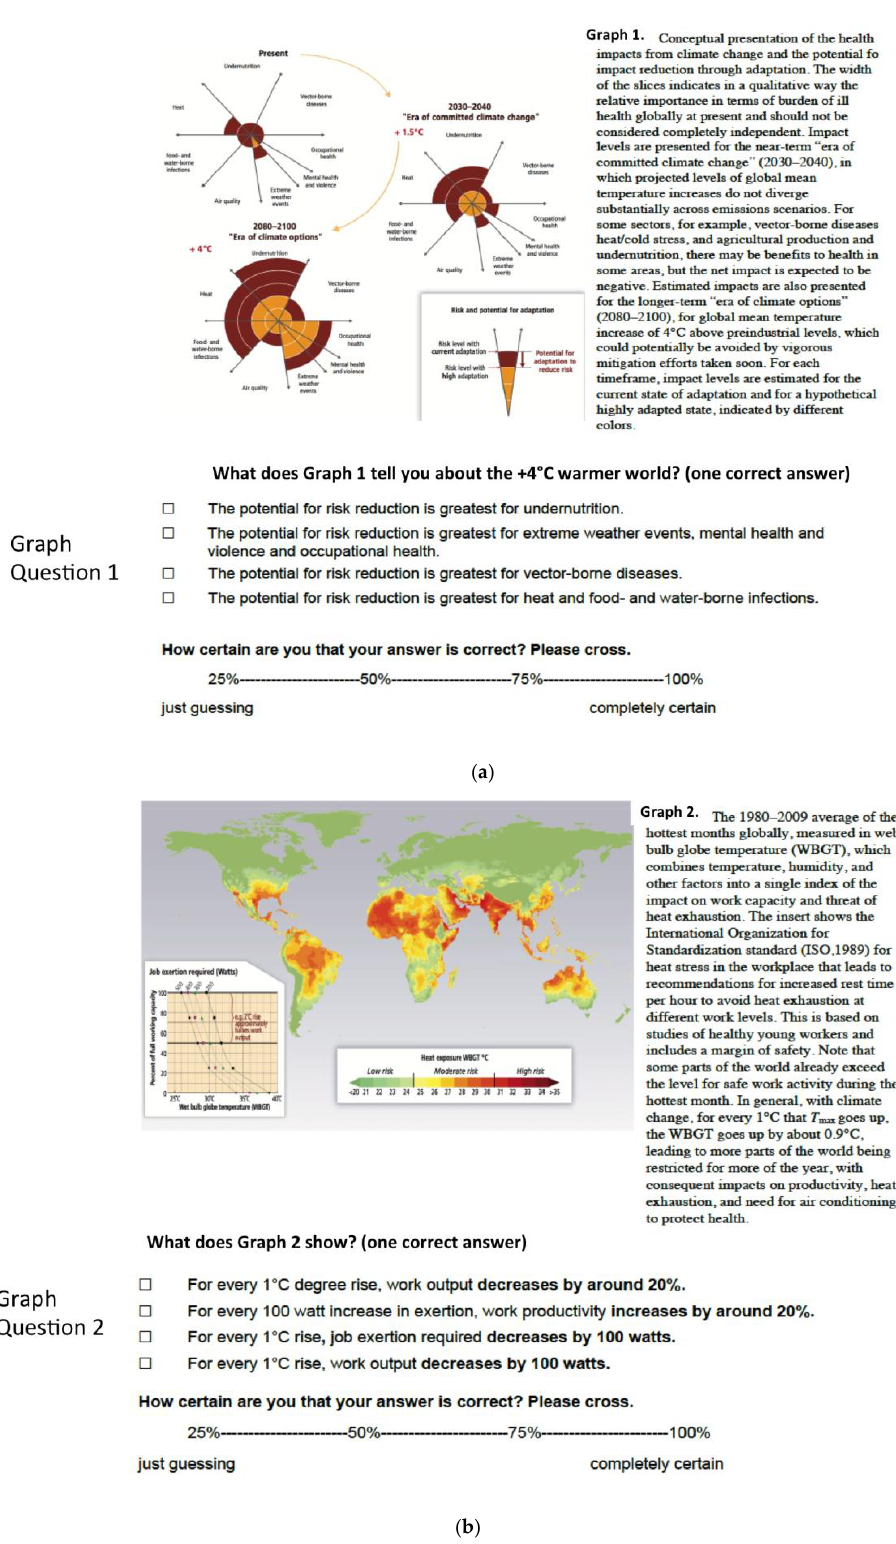
Figure A1. Health chapter graphs and questions. ( a ) Graph 1 together with graph question 1. ( b ) Graph 2 together with graph question 2.